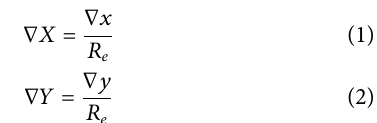
Frontiers in Earth Science |